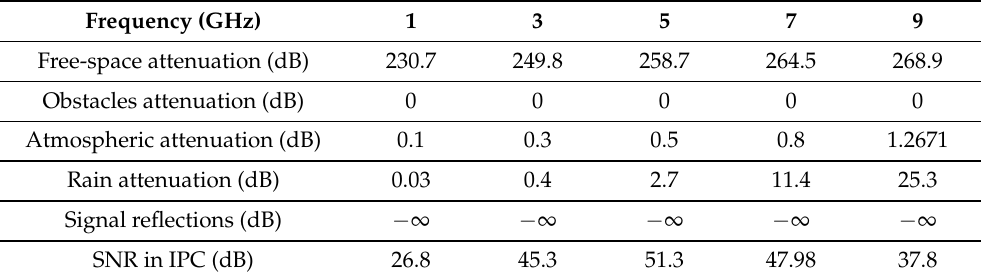
Table 4. System elements with passive repeater addition for the simulated terrestrial project.